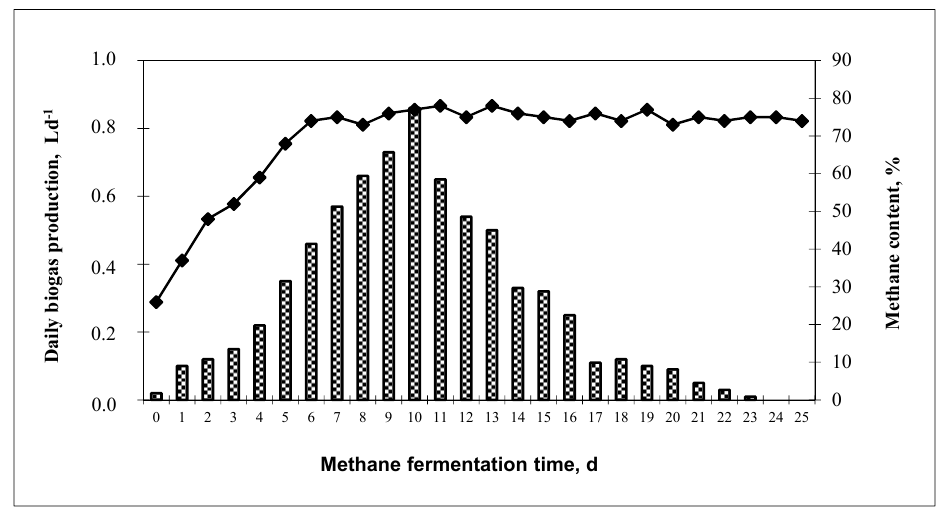
Figure 5. The biogas production process, including methane content, recorded in the process of anaerobic stabilization of unprepared excess sludge.